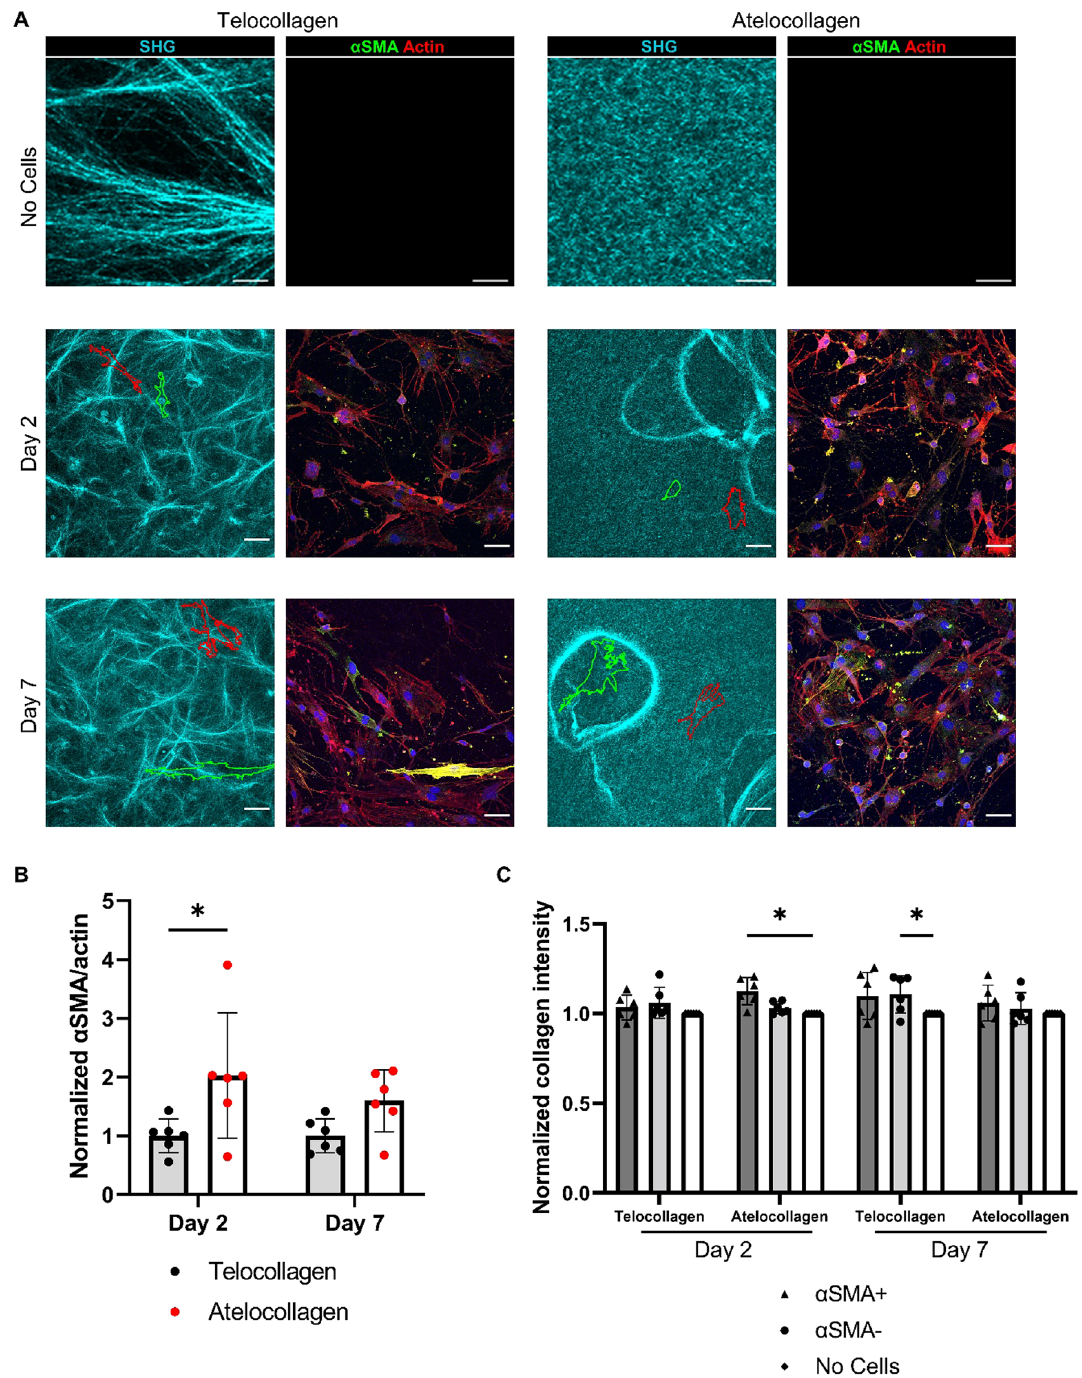
Figure 4. SHG imaging of 3 mg/ml crosslinked and non-crosslinked collagen gels. ( A ) SHG images of collagen and FAP cells. Red outlines indicate a αSMA− FAP and green outlines indicate a αSMA+ FAP. Scale bars on no cell images set to 10 μm. Scales bars on day 2 and day 7 images set to 50 µm. ( B ) αSMA and actin area ratio after 2 and 7 days on the collagen gels. ( C ) Collagen intensity of gels under αSMA+ or αSMA− cells, or under no cells normalized to areas of collagen without any cells. * P < 0.05 using a two-way ANOVA with multiple comparisons using Tukey correction. N = 2 independent gels and n = 3 fields per